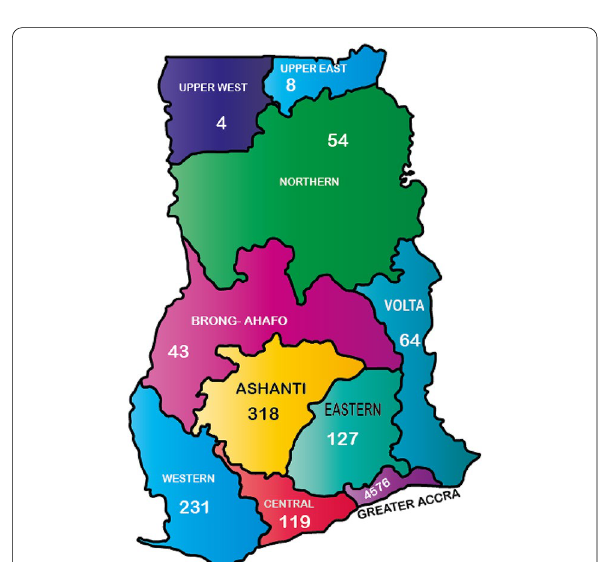
Fig. 3 Map showing regional distribution of FDI projects. Source GIPC, 2018 & Authors’ Construct, 2022